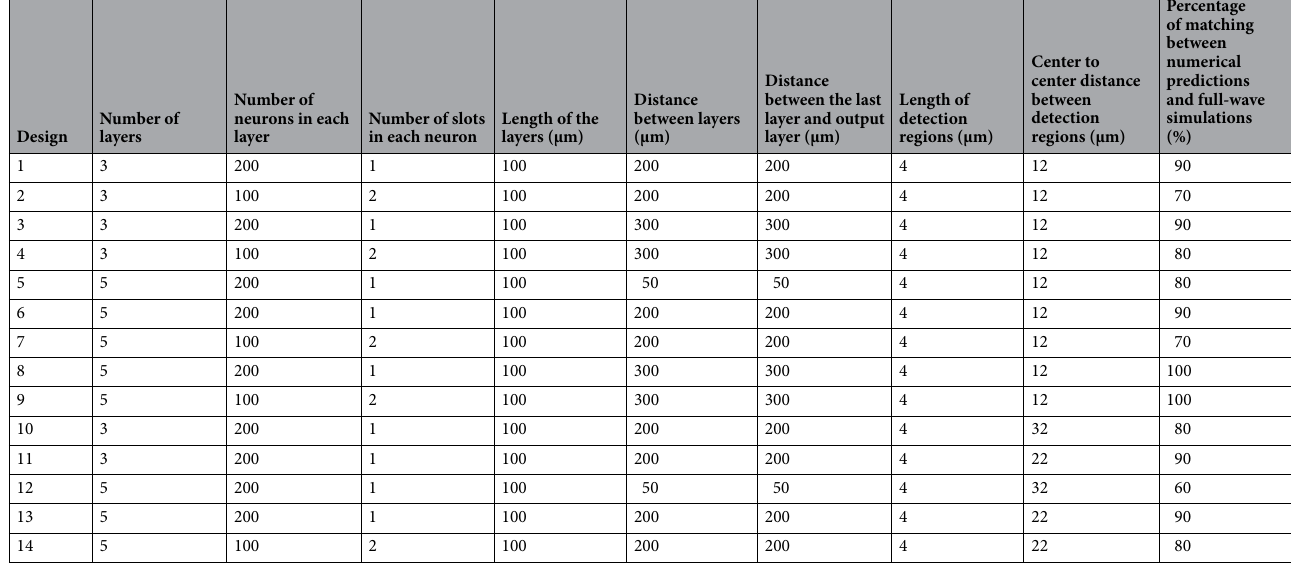
Table 2. The characteristics of a number of diffractive neural networks that operate as a multi-functional logic gate and the matching between their numerical testing results and full-wave simulation results.